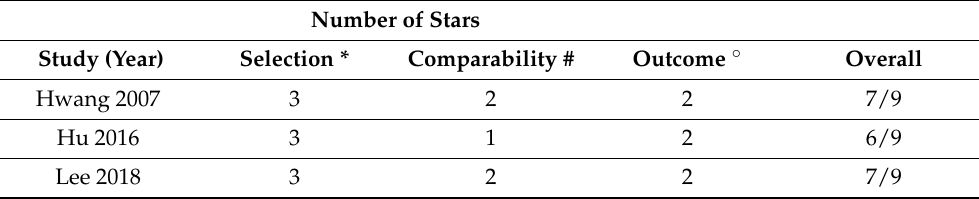
Table 4. Summary of risk of bias assessment using NOS system.